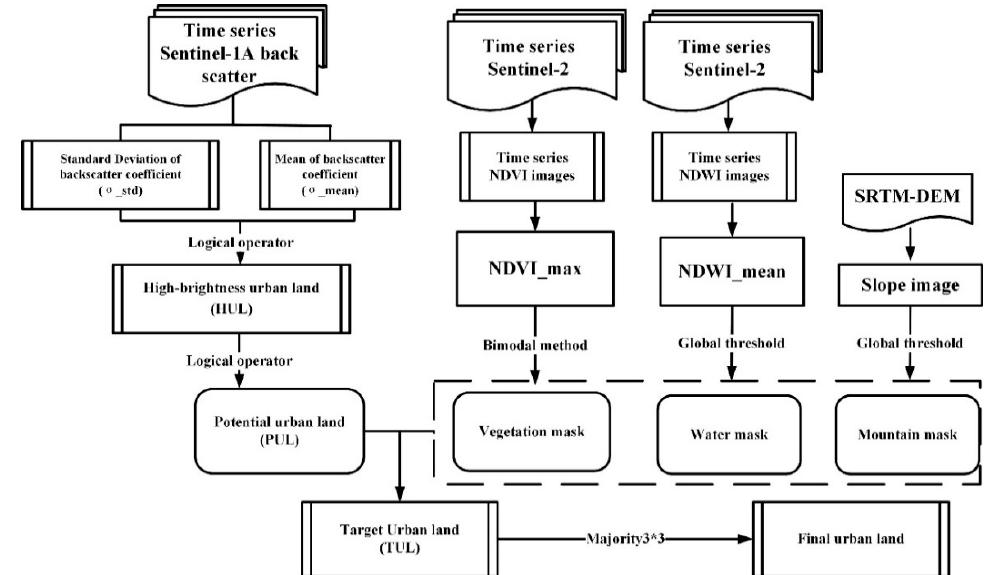
Figure 1. The flow chart for generating an urban land map.